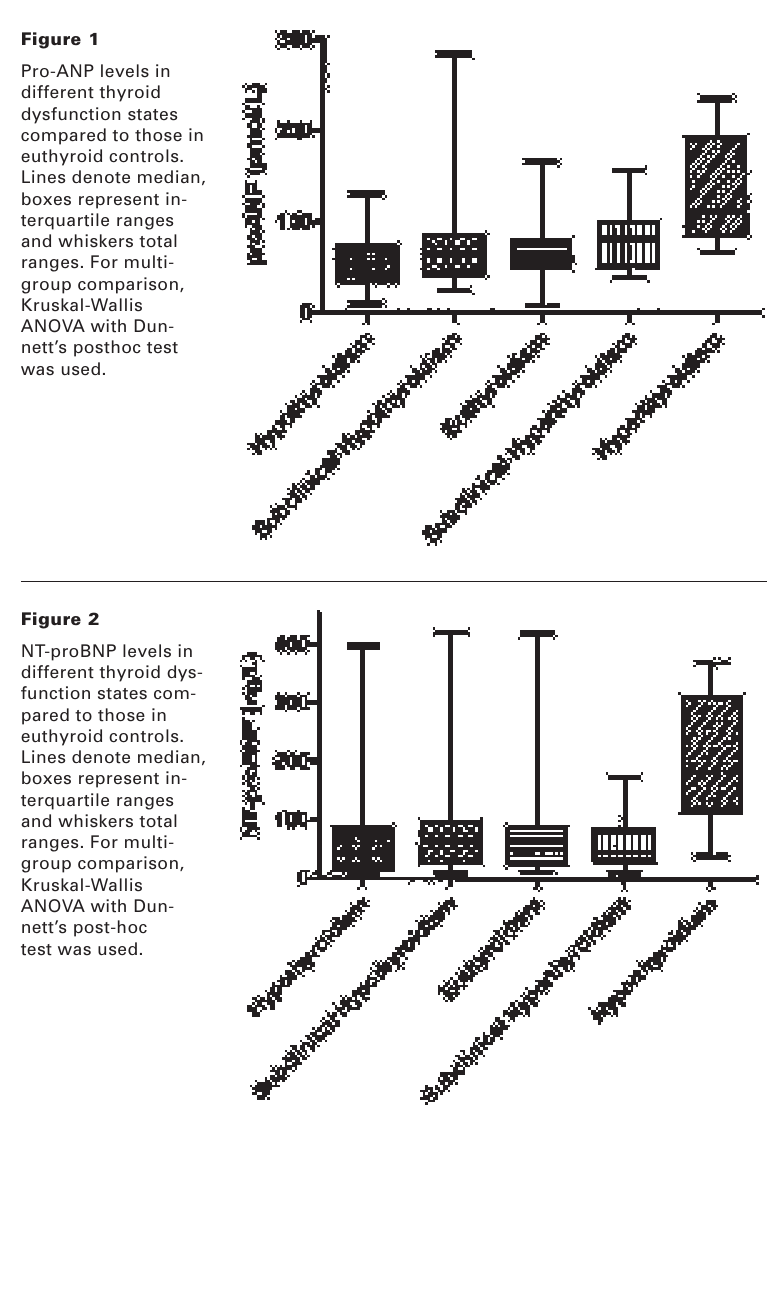
Figure 1 Pro-ANP levels in different thyroid dysfunction states compared to those in euthyroid controls. Lines denote median, boxes represent in- terquartile ranges and whiskers total ranges. For multi- group comparison, Kruskal-Wallis ANOVA with Dun- nett’s posthoc test was used.